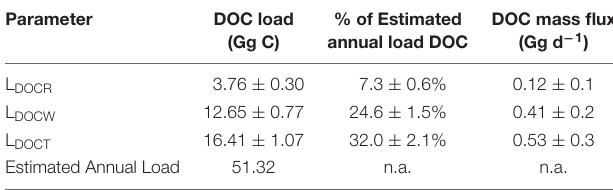
TABLE 3 | Calculated load of DOC exported by Hurricane Matthew’s floodwaters for the Neuse River, wetlands, and the NRE.